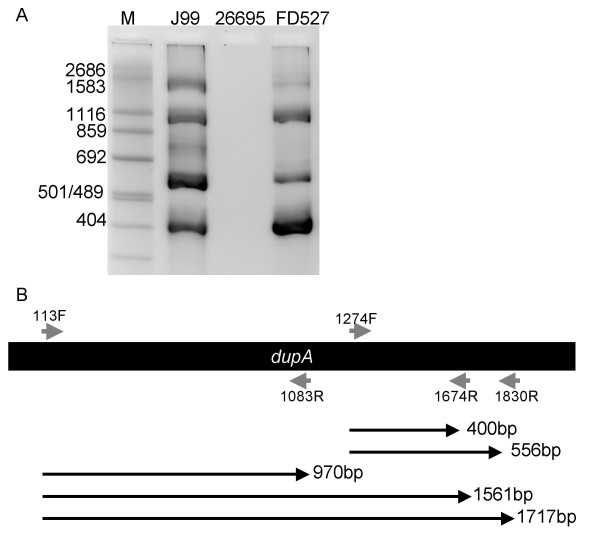
PCR amplification using the dupA multiplex PCR. (A)Genomic DNA from H. pylori strains J99 (positive control), 26695 (negative control) and FD527 (clinical isolate) were used to PCR amplify dupA using the forward primers dupA113F and dupA1274F, and the reverse primers dupA1083R, dupA1674R and dupA1830R. M, size markers (in base pairs). (B) Schematic representation of dupA showing the annealing positions of the forward primers dupA113F and dupA1274F, and the reverse primers dupA1083R, dupA1674R and dupA1830R, and the expected sizes of the amplified PCR products.